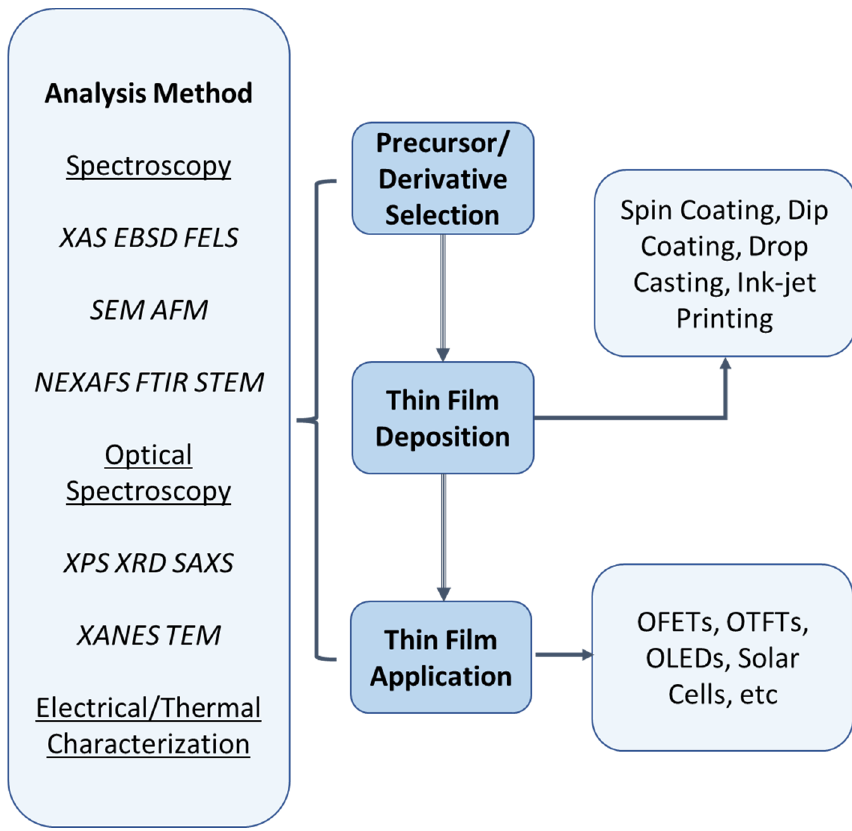
Figure 4. Soluble thin films—analysis, deposition, and applications.